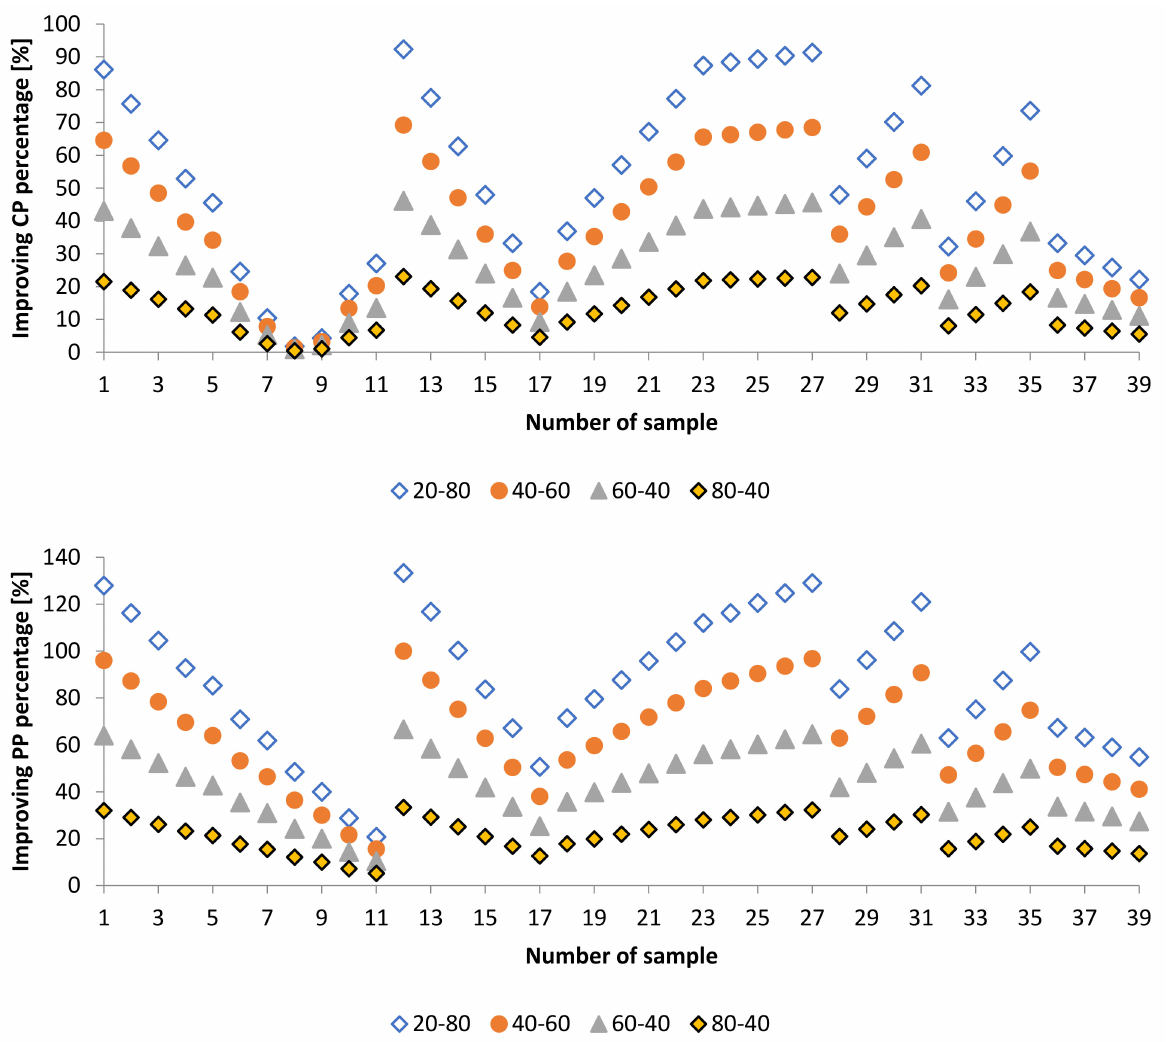
Figure 5. Improving cold flow percentage of the mixture (PME-WFME) with various ratios (20:80 means 20% v / v of palm oil biodiesel and 80% v / v of waste frying oil biodiesel; 40:60 means 40% v / v of palm oil biodiesel and 60% v / v of waste frying oil biodiesel; 60:40 means 60% v / v of palm oil biodiesel and 40% v / v of waste frying oil biodiesel; and 80:20 means 80% v / v of palm oil biodiesel and 20% v / v of waste frying oil